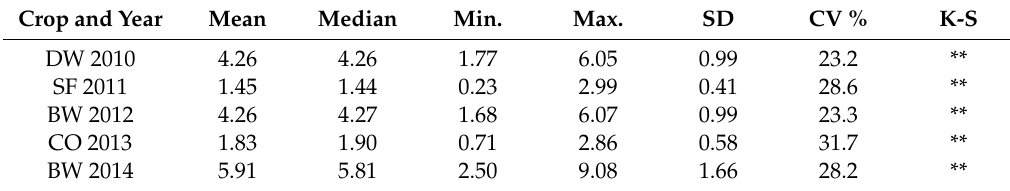
Table 4. Descriptive statistics of crop yields (t ha − 1 ) in the five